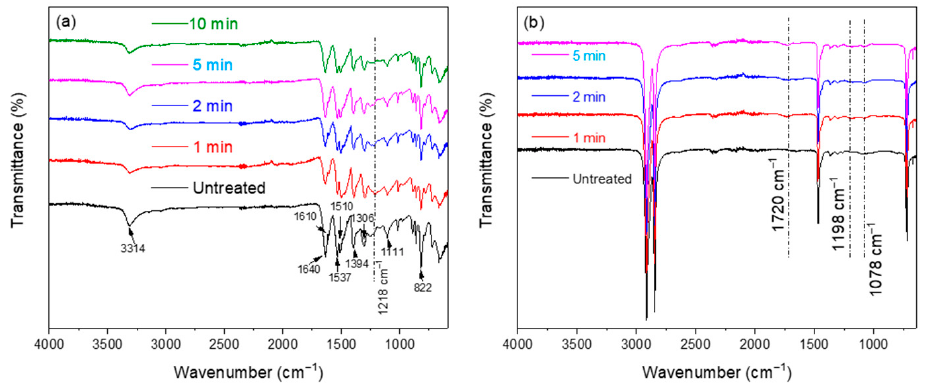
Figure 6. FTIR spectra of PPTA ( a ) and UHMWPE ( b ) treated for different times.